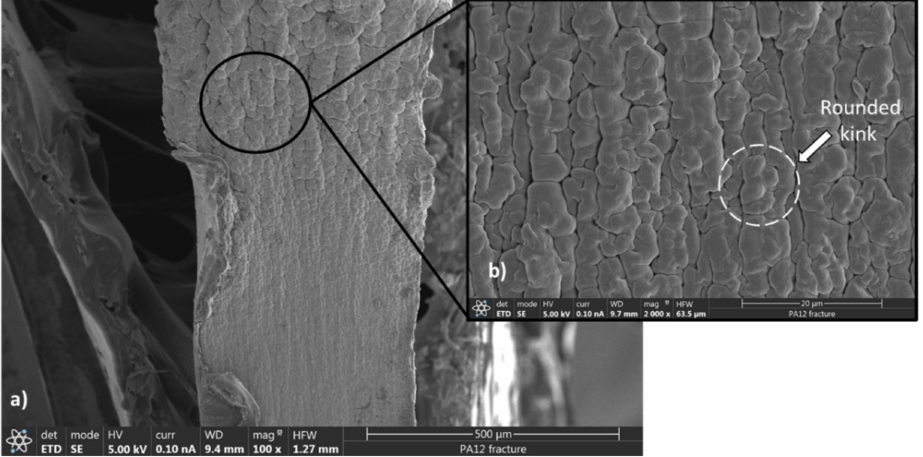
Figure 7. SEM micrographs of the PA12 fracture surface: ( a ) magnification of 100 × , ( b ) magnification of 2000 × .